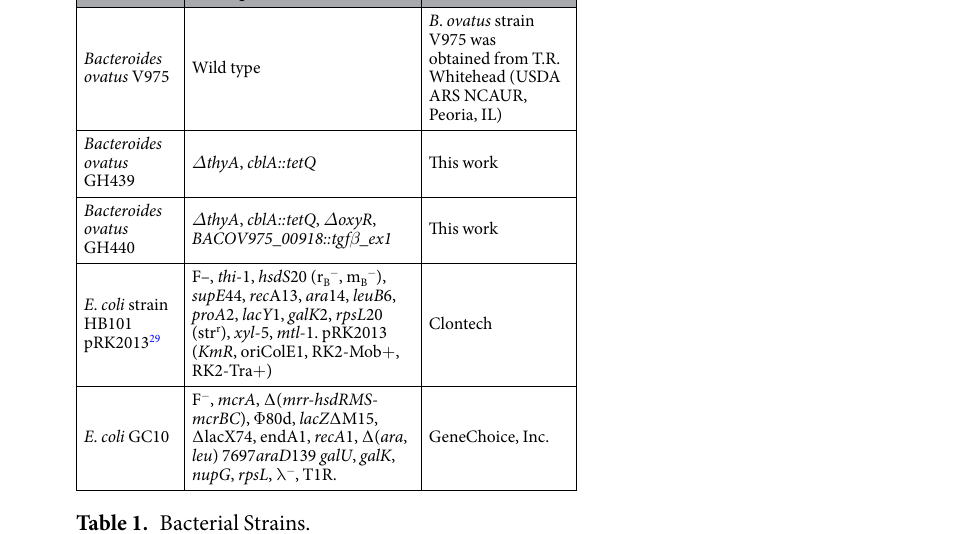
Table 1. Bacterial